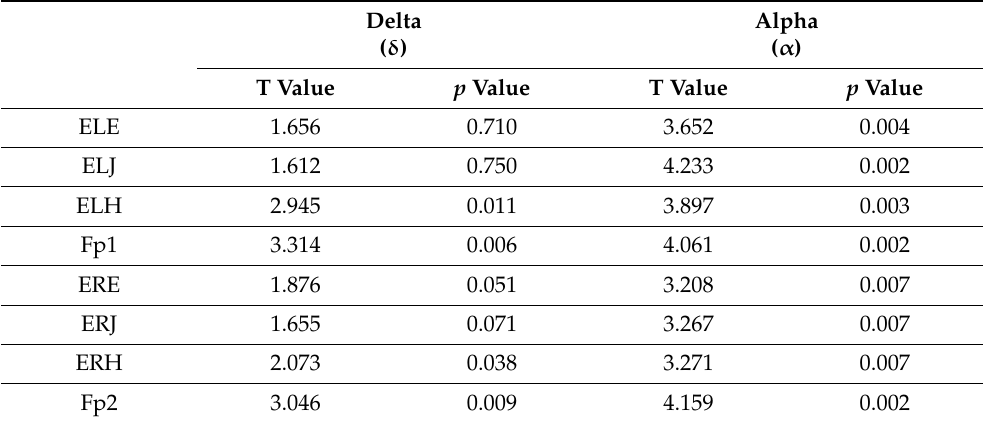
Table 4. t test statistics of electrodes in the left and right ear between eyes-open and eyes-closed